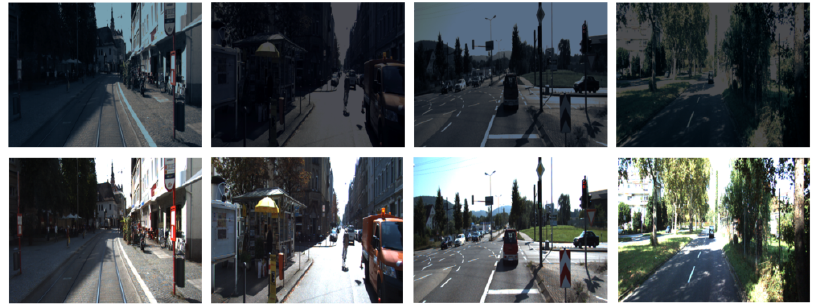
Figure 7. Synthetic night frames ( top row) and original images ( bottom